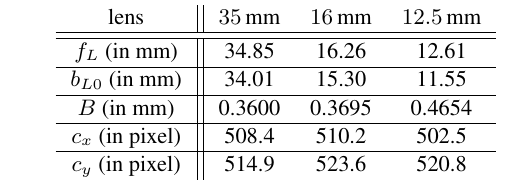
Table 1. Estimated intrinsic parameters of the proposed focused plenoptic camera model for different main lens focal length. Table 2. Comparison of the reprojection error using a pinhole camera model as well as our proposed focused plenoptic camera model for different main lens focal